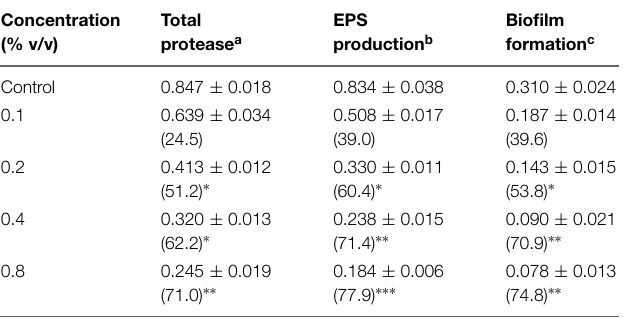
TABLE 2 | Effect of sub-MICs of PMO on inhibition of quorum sensing regulated virulence factors in Aeromonas hydrophila